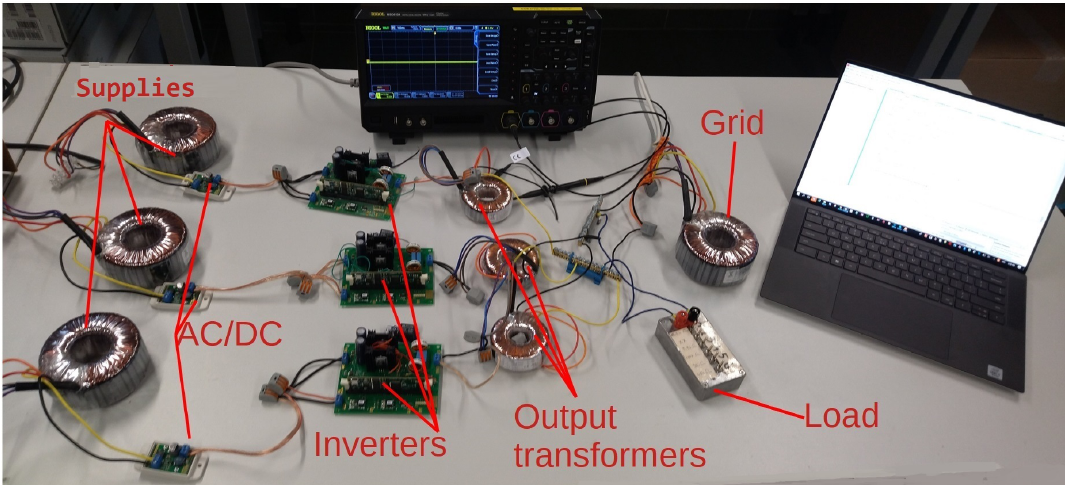
Figure 5. Physical testing